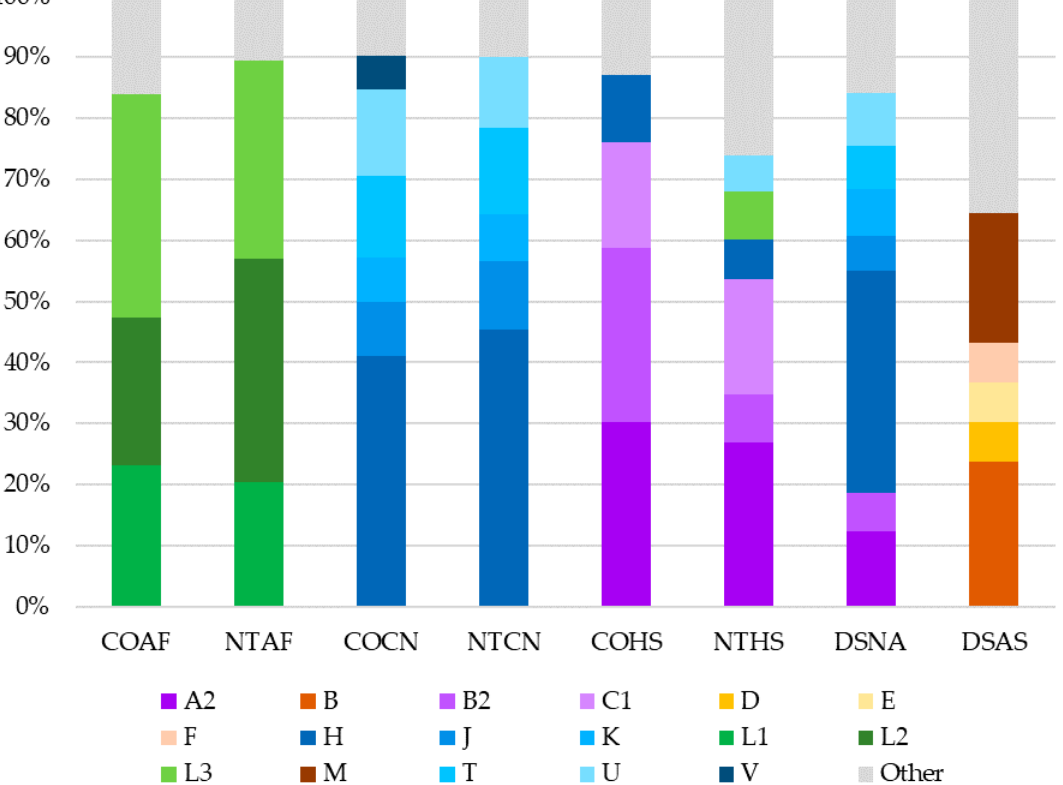
Figure 5. Proportions of haplogroups observed within each dataset. African haplogroups are green, European haplogroups are blue, Native American haplogroups are purple, and Asian haplogroups are orange. Haplogroups representing less than 5% of haplotypes within each dataset have been grouped together and are shaded in grey. For complete haplogroup distribution and frequencies, see Table S8. COAF = Colorado African American; NTAF = National Institute of Standards and Technology (NIST) African American; COCN = Colorado Caucasian; NTCN = NIST Caucasian; COHS = Colorado Hispanic; NTHS = NIST Hispanic; DSNA = Department of Defense Serum Repository (DoDSR) Native American; DSAS = DoDSR Asian American.